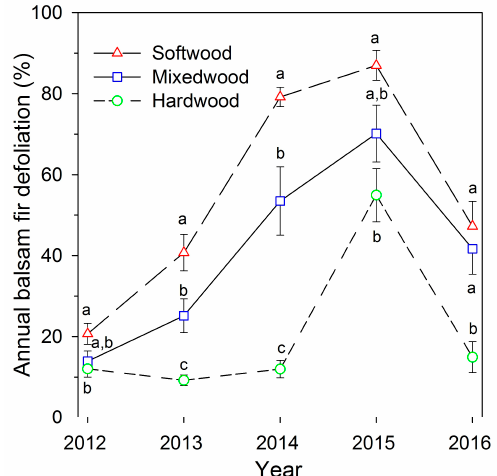
Figure 2. Measured balsam fir defoliation and fitted relationships from generalized linear mixed-effects model to test the effects of percent hardwood content on annual plot defoliation from 2012 to 2016, for 27 plots near Amqui, Quebec.